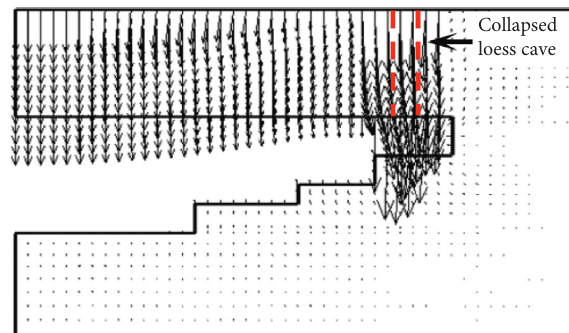
Figure 27: Vector diagram of settlement during passing through the collapsed loess cave.